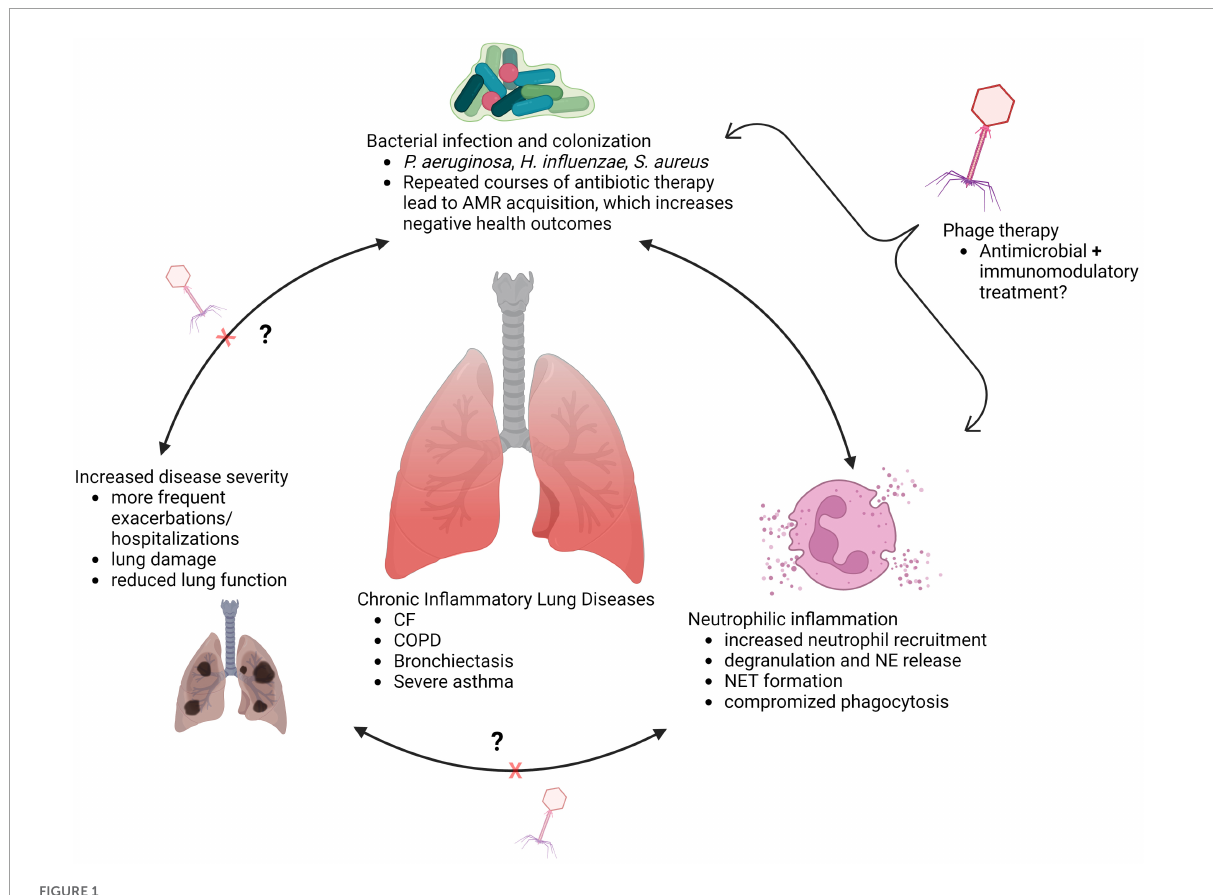
FIGURE1 Interplay between infection and inflammation in chronically diseased lungs (created with